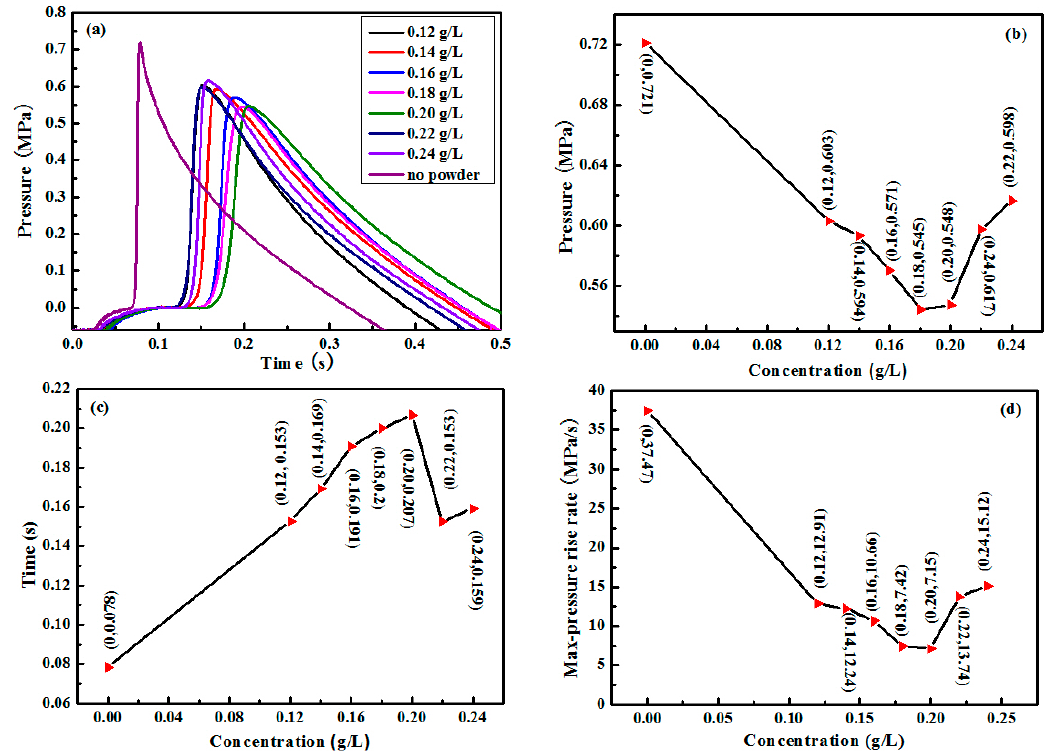
Figure 7. The suppressing effect of pristine palygorskite powders with different concentrations on methane explosion: ( a ) the curves of explosion pressure; ( b ) the values of pressure peak; ( c ) the time on the pressure peak; and ( d ) the rising rate max-pressure.